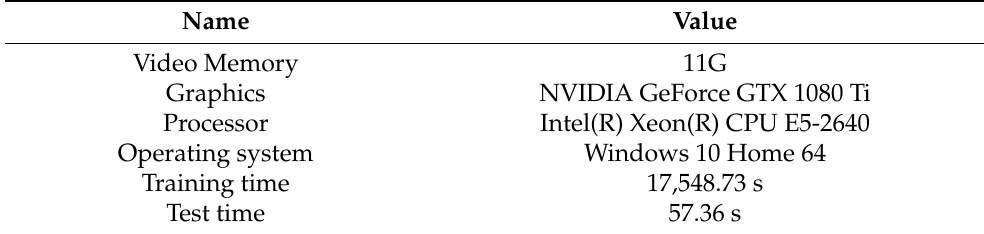
Table 1. Machine specifications and time cost.